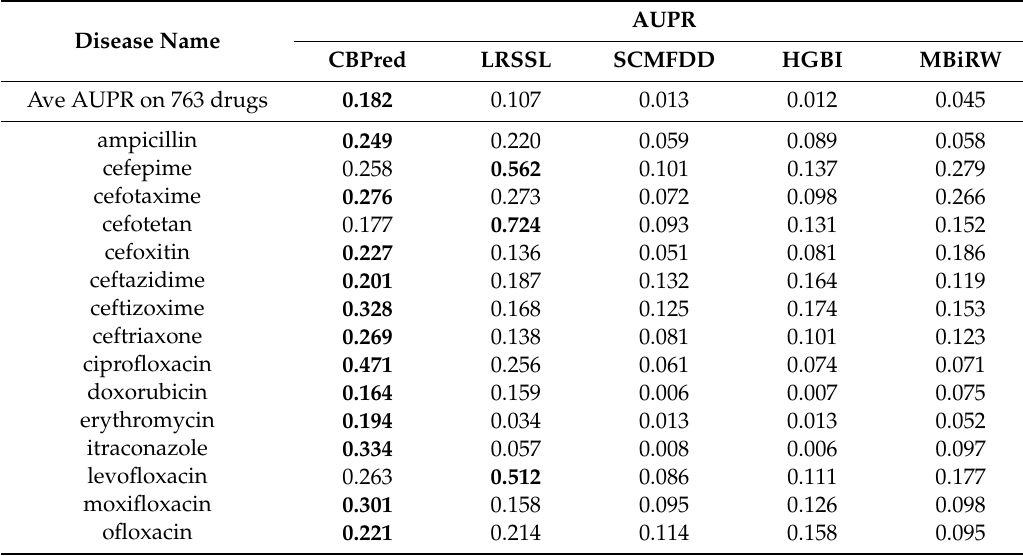
Table 2. Prediction results of CBPred and four other contrast methods for 15 drugs in terms of the area under the precision–recall curve (AUPR).